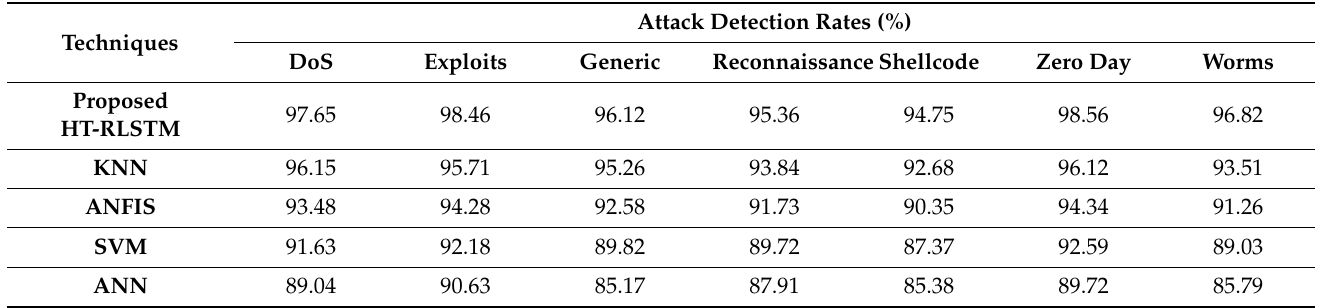
Table 1. Performance analysis of the proposed HT-RLSTM based on attack detection